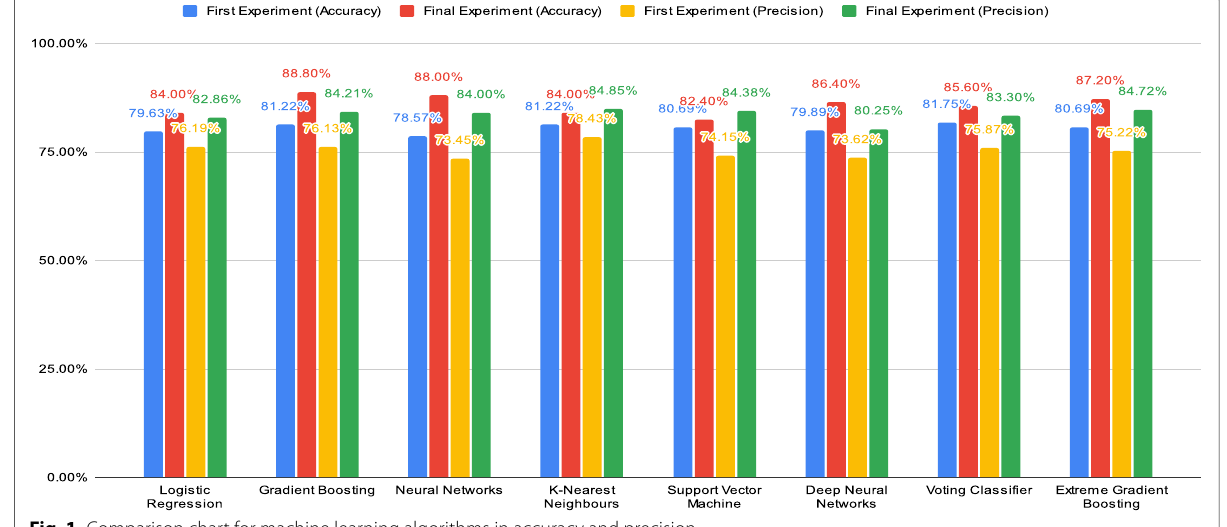
Fig. 1 Comparison chart for machine learning algorithms in accuracy and precision